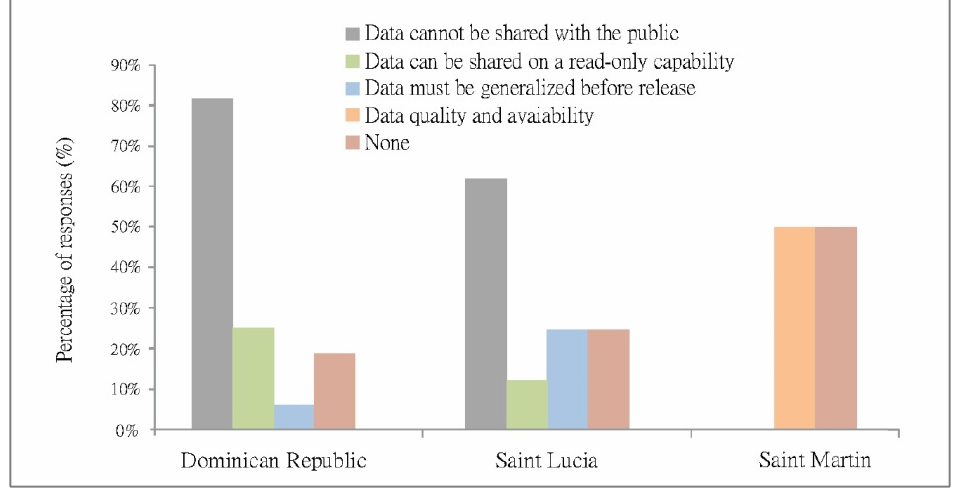
Figure 8. Restrictions using EMT data (Q21).